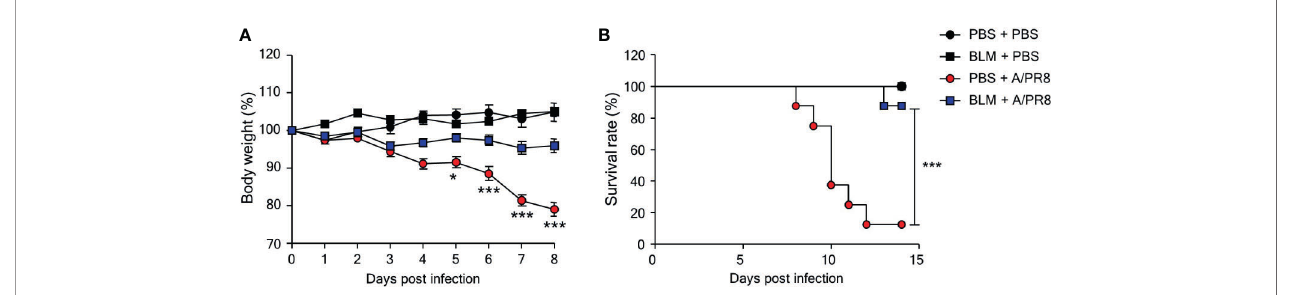
FIGURE 1 | Bleomycin (BLM) treatment increases resistance to in fl uenza virus infection. Mice were intranasally administered BLM or PBS 14 days before infection. (A) Mice were intranasally infected with sub-lethal doses and body weights were monitored for 7 days ( ● , n = 2; ■ , n = 3; ● , n = 8; ■ , n = 11). (B) Mice were intranasally infected with lethal doses, and survival rates were monitored ( ● , n = 4; ■ , n = 4; ● , n = 8; ■ , n = 8). Data are expressed as mean ± SEM and representative of 2 independent experiments. Statistical analyses of body weight and survival rates were performed using Two-way ANOVA and the Mantel-Cox test, respectively (* p < 0.05, *** p < 0.001).